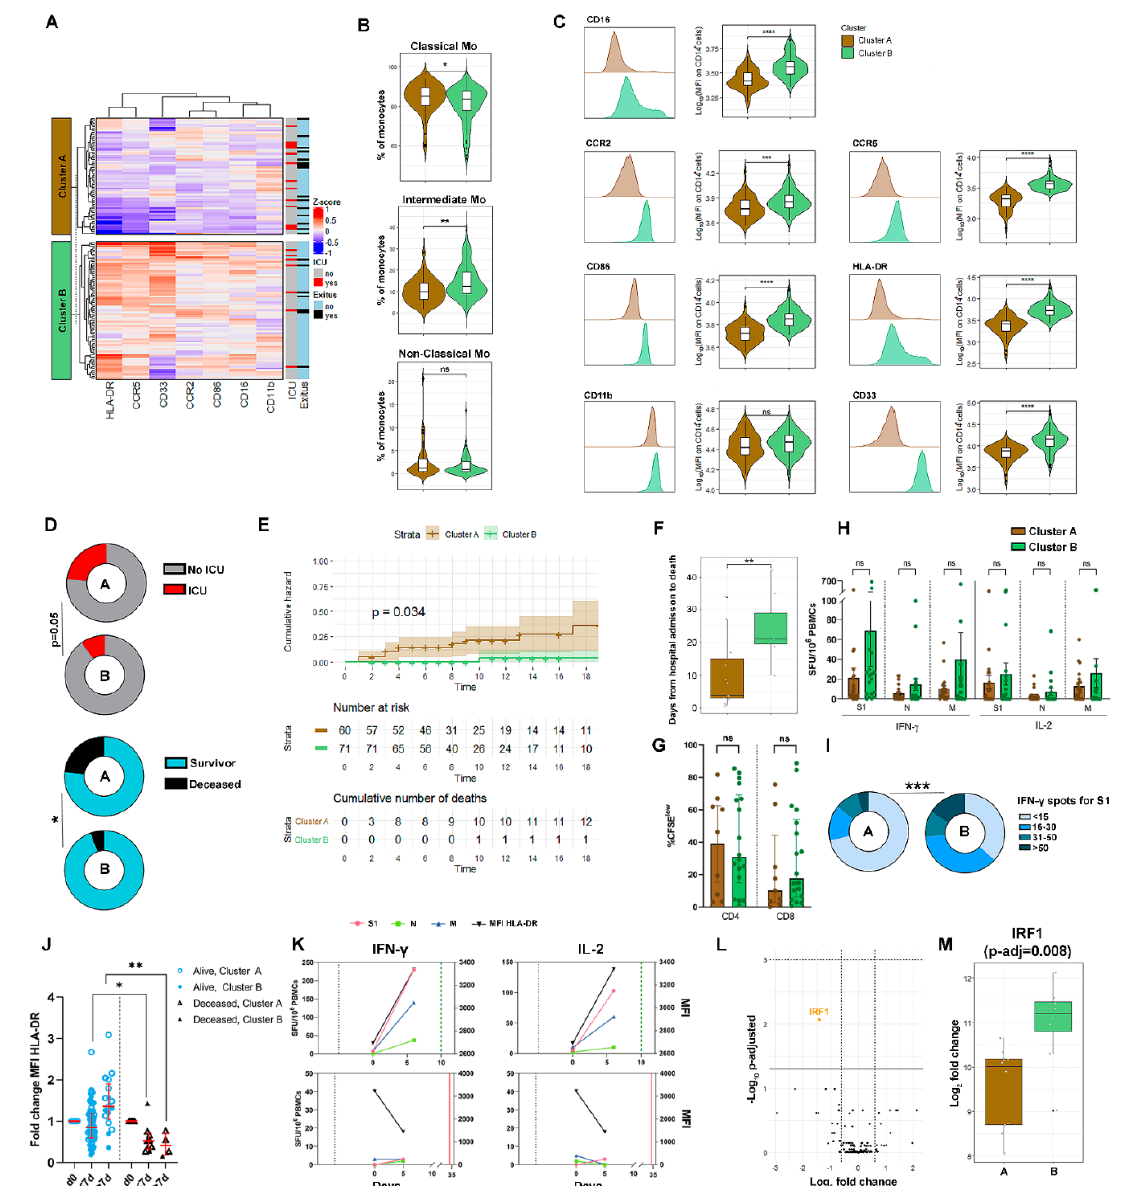
Figure 5. Acute COVID-19 patients with low expression of surface molecules in monocytes have higher risk of ICU requirement or death. ( A ) K-means clustering heatmap of monocyte surface markers from acute COVID-19 patients at ER arrival identified two separate clusters ( A , B ) of acute COVID-19 patients. ( B ) Cluster A acute COVID-19 patients showed a significantly higher proportion of classical monocytes, and lower proportion of intermediate monocytes, when compared to cluster B. ( C ) Comparison of monocyte surface markers between clusters. ( D ) Differences in ICU requirement and death rate in cluster A versus cluster B. ( E ) Cumulative death Kaplan-Meier analysis of hospitalized cluster A and B acute COVID-19 patients. ( F ) Interval from hospitalization to death in cluster A and B patients. ( G ) Polyclonal CD4 and CD8 T cell proliferation in cluster A and B patients. ( H ) IFN- γ and IL-2 specific T cell response against S1, N and M peptides of SARS-CoV-2 in cluster A and cluster B patients. ( I ) Cluster B patients had higher number of S1 specific T cells at ER arrival. ( J ) Follow-up of HLA-DR expression in monocytes during hospitalization showed augmentation in surviving patients and decrease in patients who died. ( K ) Follow-up of specific S1, N and M T cell response and HLA-DR expression on monocytes in two representative patients, a survivor (top) and a non-survivor (down). X-axes represent total days (Days of symptoms: <0; days of hospitalization: >0; Day 0 represents ER arrival day). Vertical black, dashed lines represent the day of symptom onset. Vertical red, solid line represents the day of dying. Vertical green, dashed line represents the day of discharge. ( L ) Volcano plot of differently up and downregulated genes between cluster A ( n = 10) and cluster B ( n = 8) monocytes. ( M ) IRF1 was significantly downregulated in cluster A. *, p < 0.05; **, p < 0.01; ***, p < 0.001; ****, p < 0.0001; ns, non-significant.